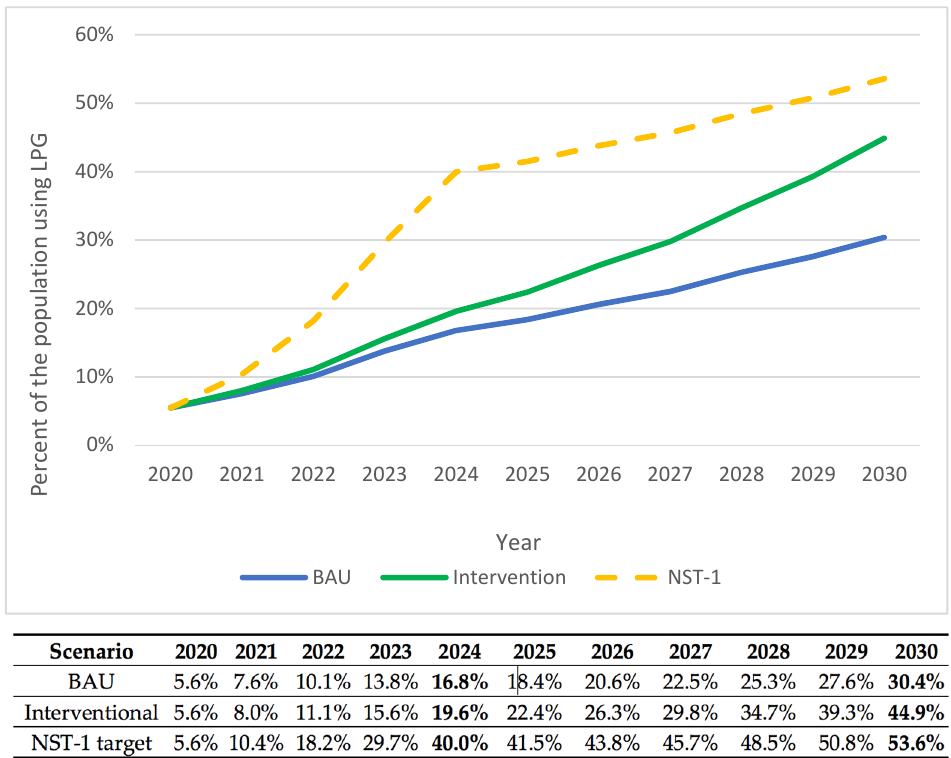
Figure 3. Proportion of population using LPG for cooking (household, institutional, and commercial use) under the three adoption scenarios.